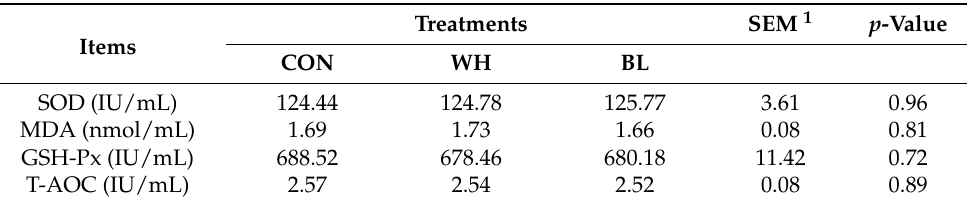
Table 3. Effects of the partial substitution of corn by wheat or barley on the blood antioxidant capacity of growing pigs.